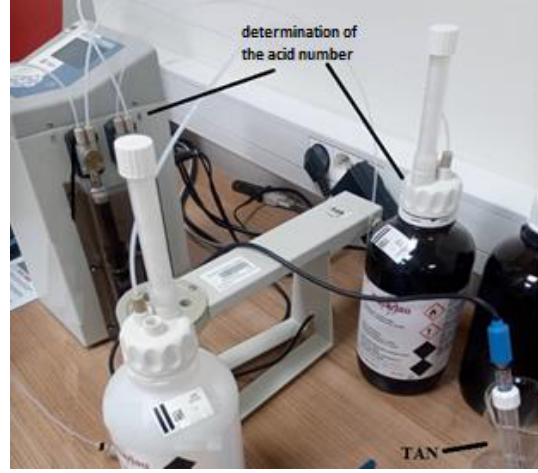
Fig. 1. Titrator TitroMatic 2S device prepared to determine the acid number Automatic titration apparatus – the TitroMatic 2S ti- trator has two replaceable burettes. Both automatic piston digital burettes can work independently or together.